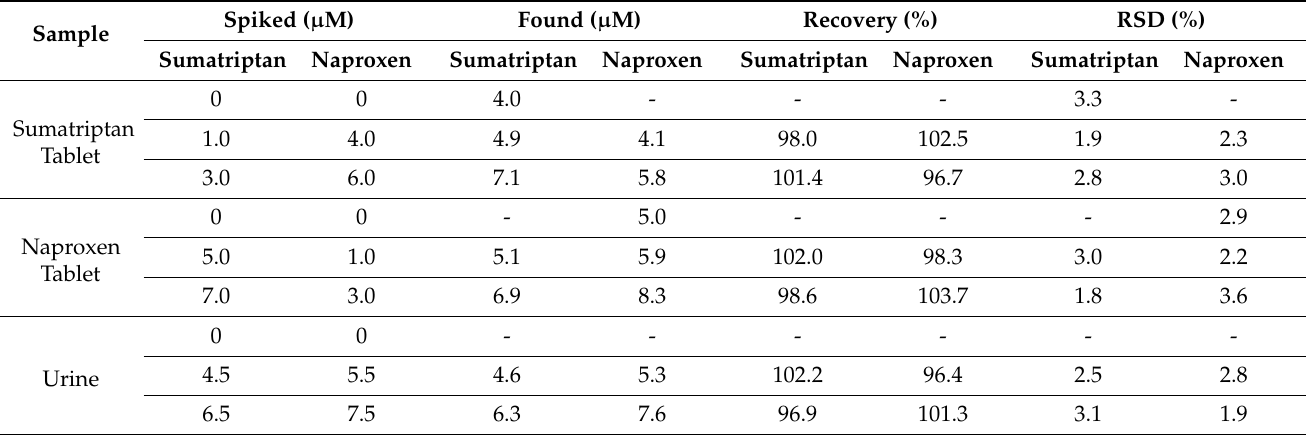
Table 2. Voltammetric sensing of sumatriptan and naproxen in real specimens using Ni-Co LDH/SPE. All concentrations are in µ A ( n =